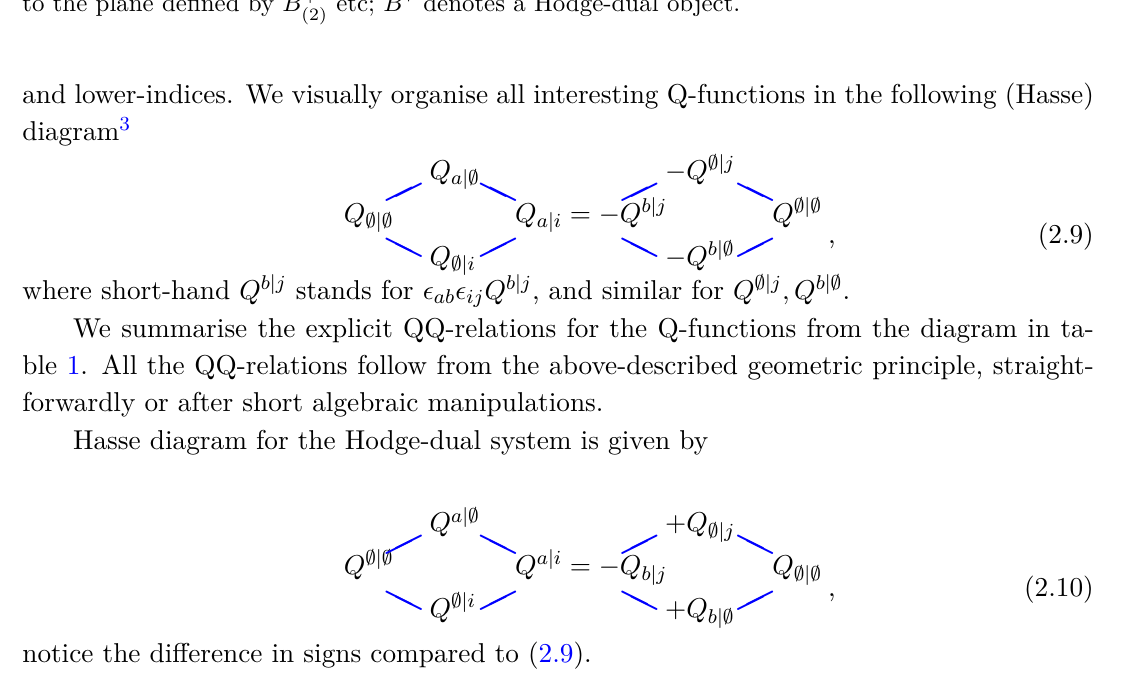
Table 1 . Explicit QQ-relations. Here e.g. B to the plane defined by B +